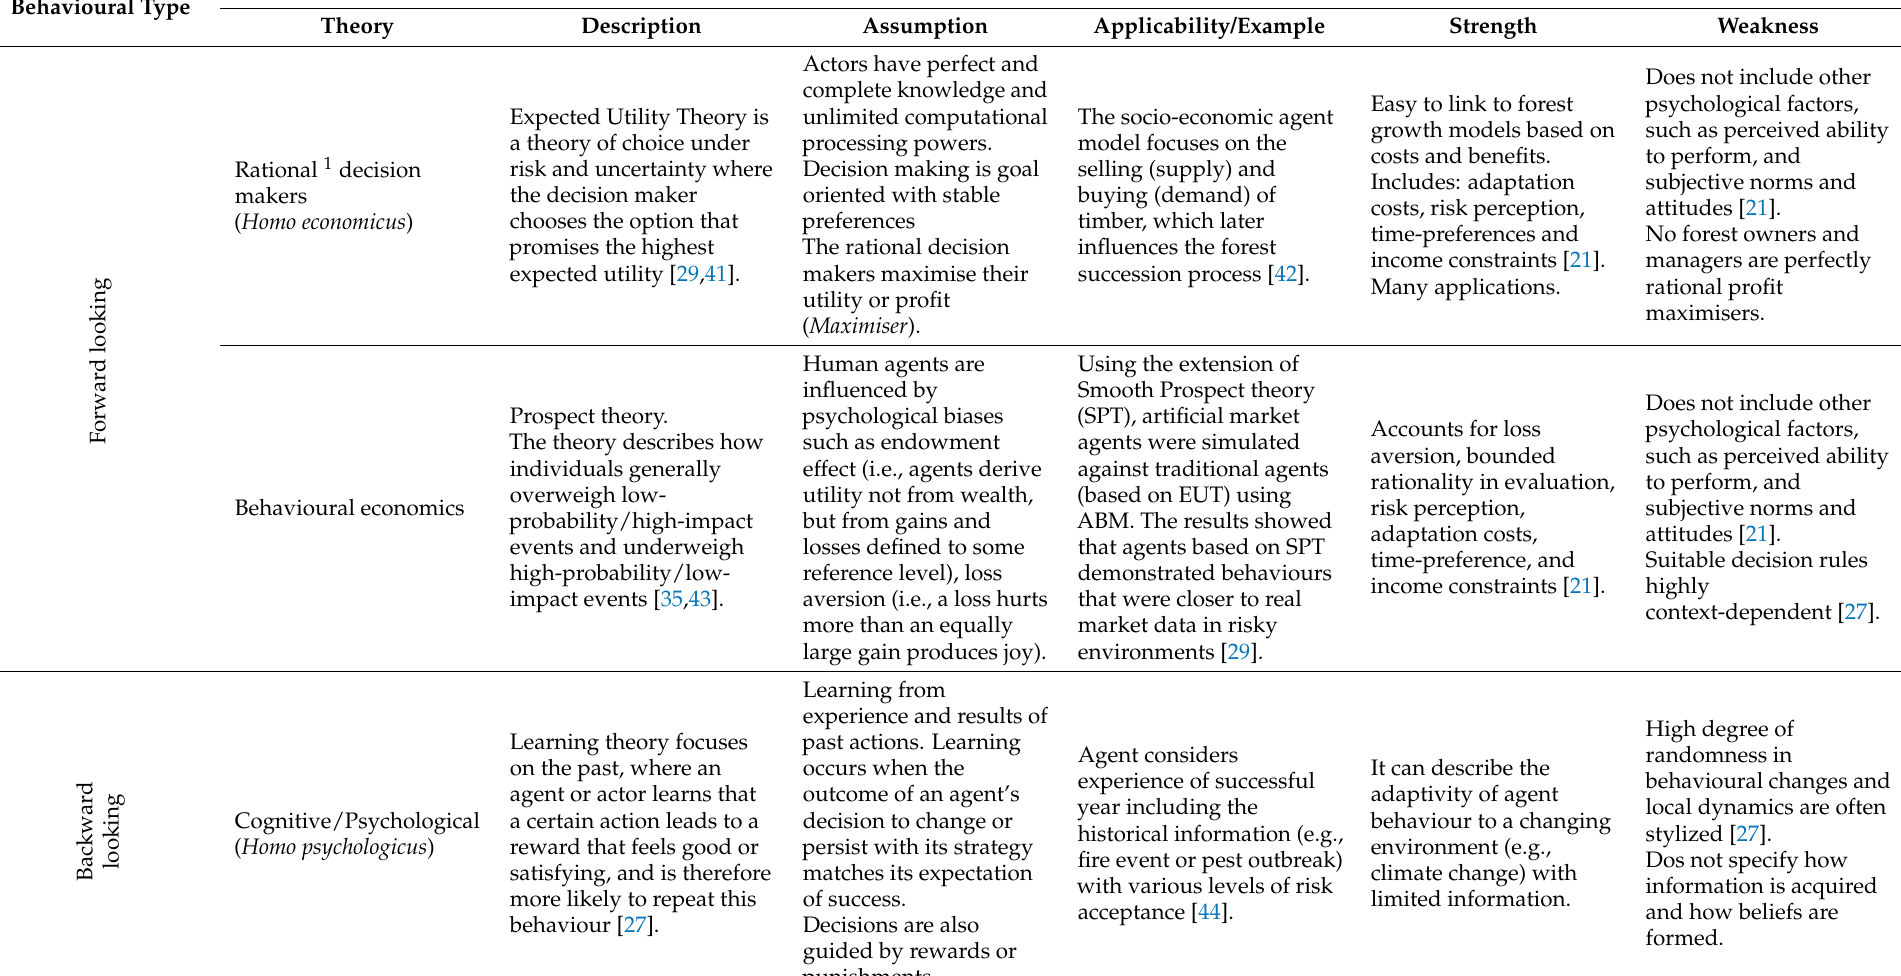
Table 1. Behavioural and decision theories for forest